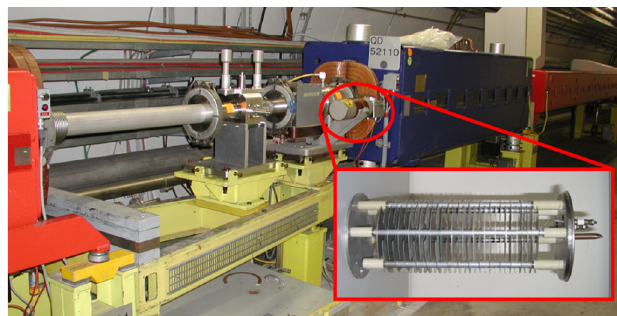
FIG. 7. (Color) The installation of a BLM (BL521) in the SPS tunnel, shown together with a close-up of the inner assembly of the chamber. stream of the collimator. BL520 and BL522 are mounted in the vertical plane below the beam line, while BL521 and BL523 are in the horizontal plane on the inside of the ring.